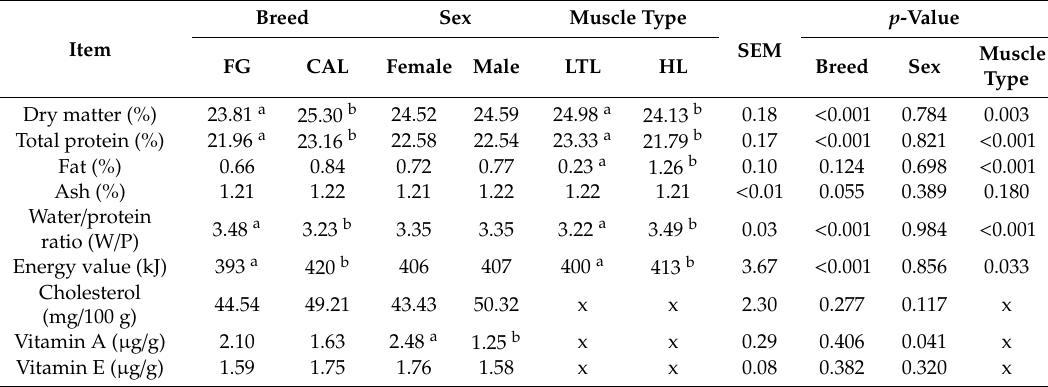
Table 2. Chemical composition of meat ( Longissimus thoracis et lumborum —LTL, hind leg—HL) from female and male Californian and Flemish Giant Gray rabbits (arithmetic means ±